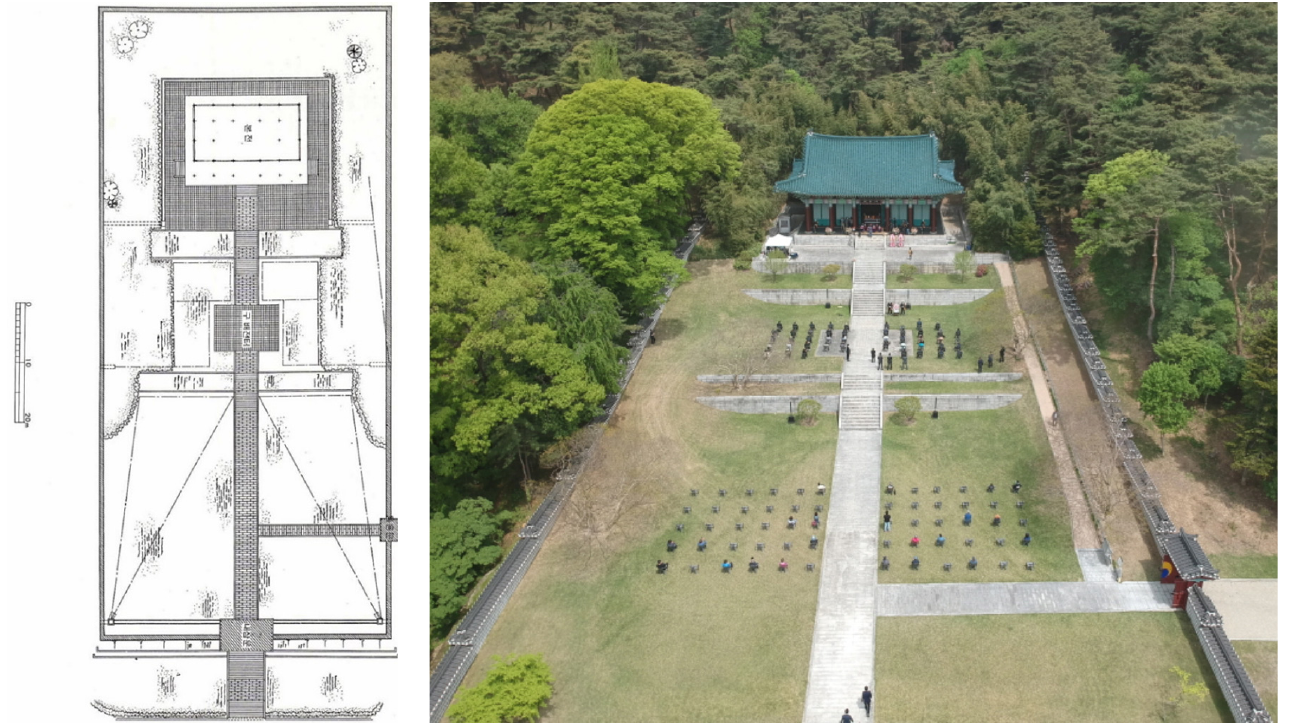
Figure 10. The Main Hall and Surrounding walls (source: Cultural Heritage Administration).